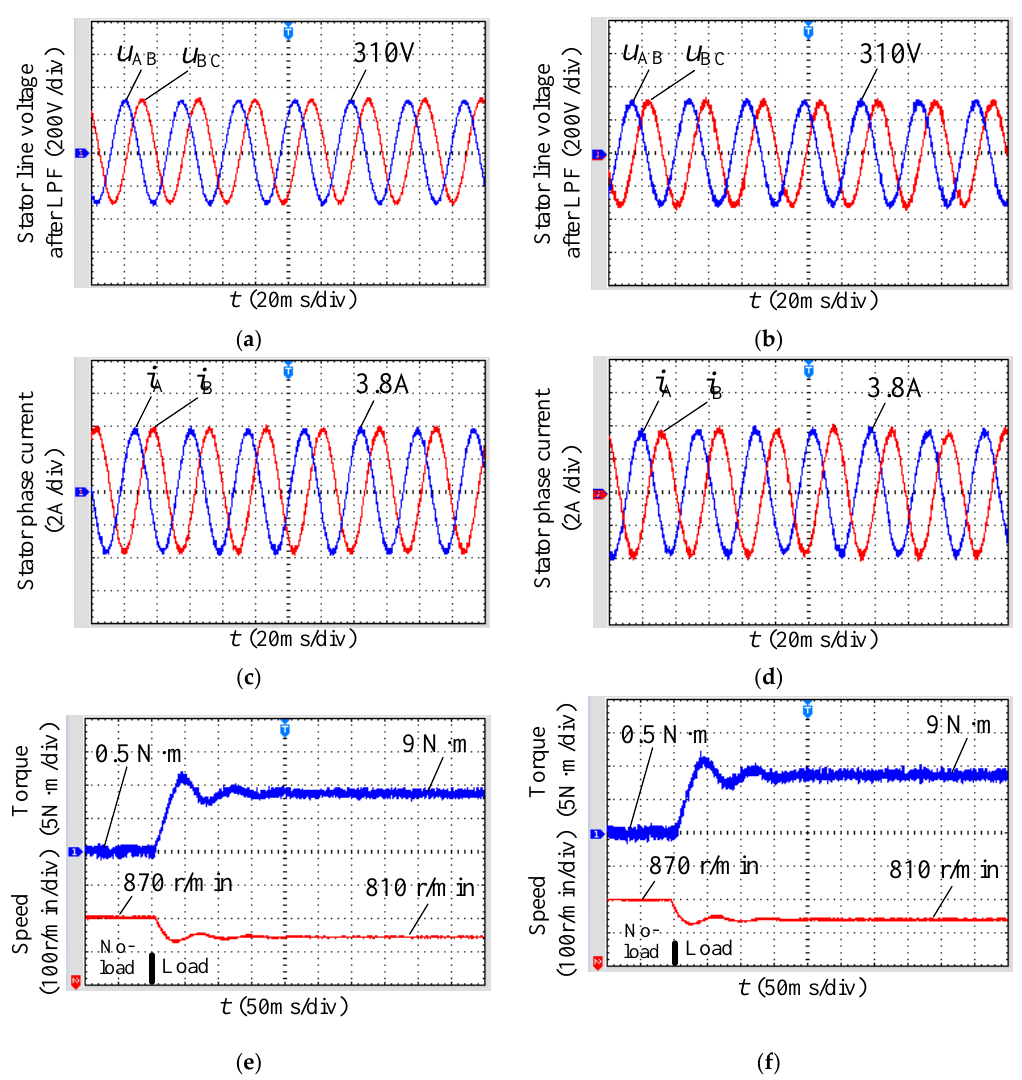
Figure 8. Experimental waveforms of stator line voltage after low-pass filtering (LPF), stator phase current, electromagnetic torque and rotor speed in the two methods. ( a ) Stator line voltage after LPF in conventional SVPWM; ( b ) Stator line voltage after LPF in CMRSVPWM; ( c ) Stator phase current in conventional SVPWM; ( d ) Stator phase current in CMRSVPWM; ( e ) Electromagnetic torque and rotor speed in conventional SVPWM; ( f ) Electromagnetic torque and rotor speed in CMRSVPWM. Figure 8a,b show the stator line voltages u AB and u BC after LPF in two methods. They are all sine waves with an amplitude of about 310 V, a frequency of 29 Hz, a phase difference of 120°.